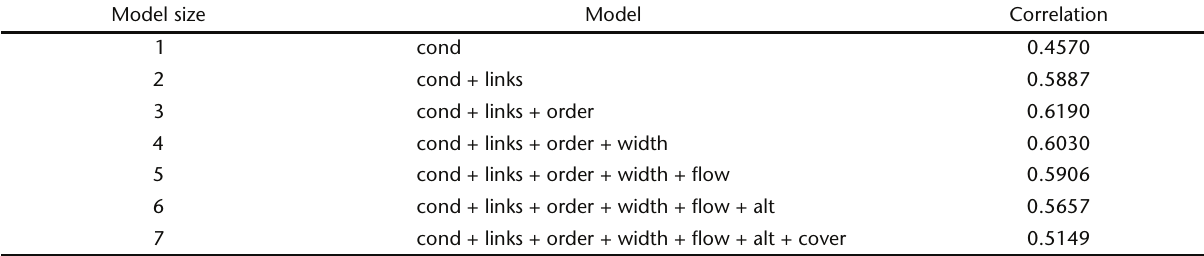
Table II. Results of the BioEnv analysis for samples collected in 10 stream sites in the Parque Estadual Intervales. (alt) Altitude, (cond) conductivity, (cover) canopy cover, (flow) discharge, (links) link magnitude, (order) stream order, (width) stream width. Units of variables can be found in table I. Correlation for the best model shown in